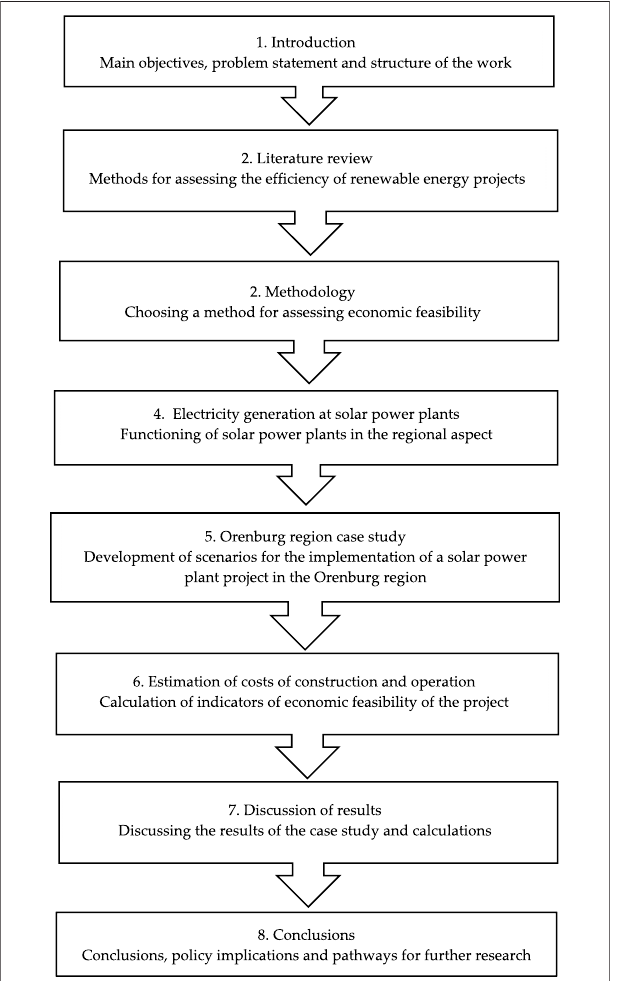
FIGURE 1 | Block diagram for the methodology highlighting various phases of the